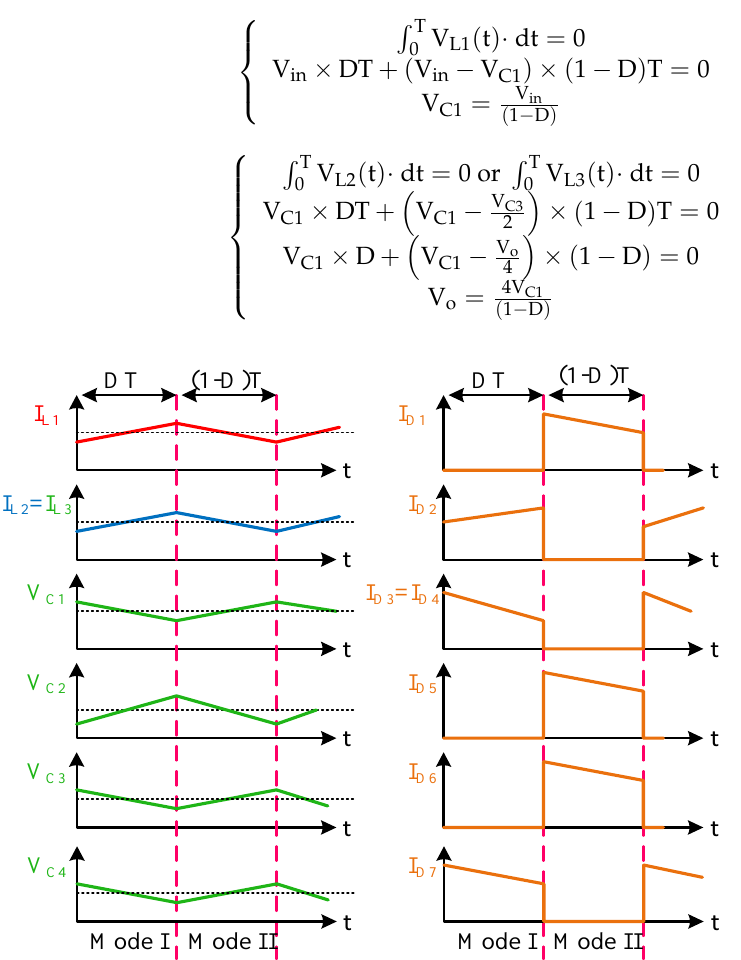
Figure 8. Typical waveforms of the proposed converter II in CCM.